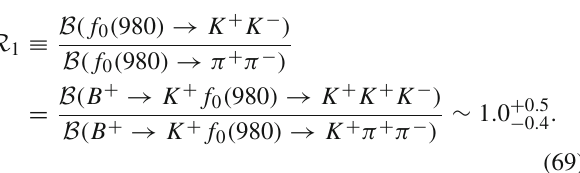
( 2010 ) for the B → K K K 2